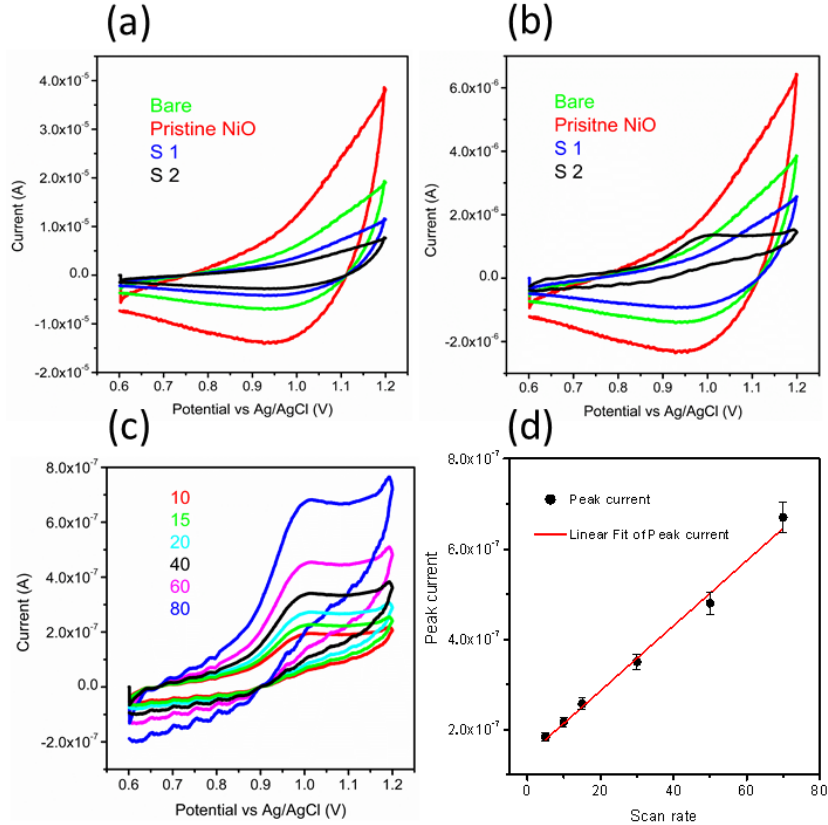
Figure 2. ( a ) CV curves of bare GCE, pristine NiO, sample 1, and sample 2 in an electrolytic solu- tion of 0.04 M BRB buffer of pH 2 at a sweeping rate of 50 mV/s; ( b ) CV curves of bare GCE, pris- tine NiO, sample 1, and sample 2 at a sweeping rate of 50 mV/s in 20 nM MTX prepared in a 0.04 M BRB buffer of pH 2; ( c ) CV curves recorded for sample 2 at different scan rates of 15, 15, 20, 40, 60, and 80 mV/s in 20 nM MTX; and ( d ) A fitting of peak current versus different scan rates.